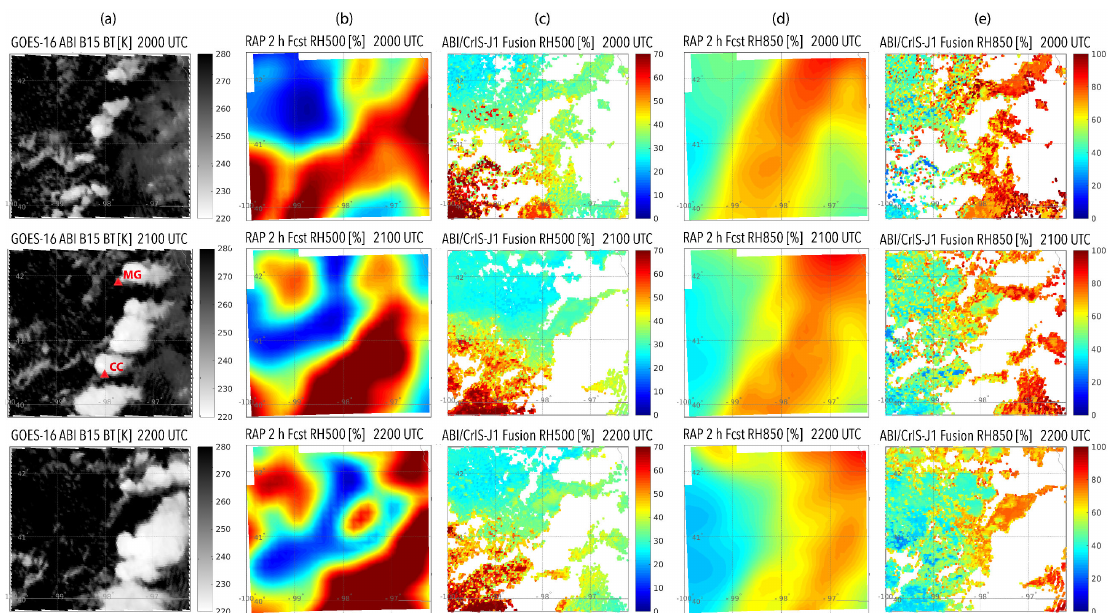
Figure 5. ( a ) ABI Band 15 (12.3 μ m) brightness temperatures (B15 BT), ( b ) RAP RH [%] at 500 hPa, ( c ) ABI/CrIS-J1 fusion RH [%] at 500 hPa, ( d ) RAP RH [%] at 850 hPa, and ( e ) ABI/CrIS-J1 fusion RH [%] at 850 hPa, for 2000 UTC ( top row), 2100 UTC ( middle row), and 2200 UTC ( bottom row) on 5 May 2021 over Nebraska. Locations of Meadow Grove (NE) and Clay Center (NE) are shown in middle panel of column ( a ).